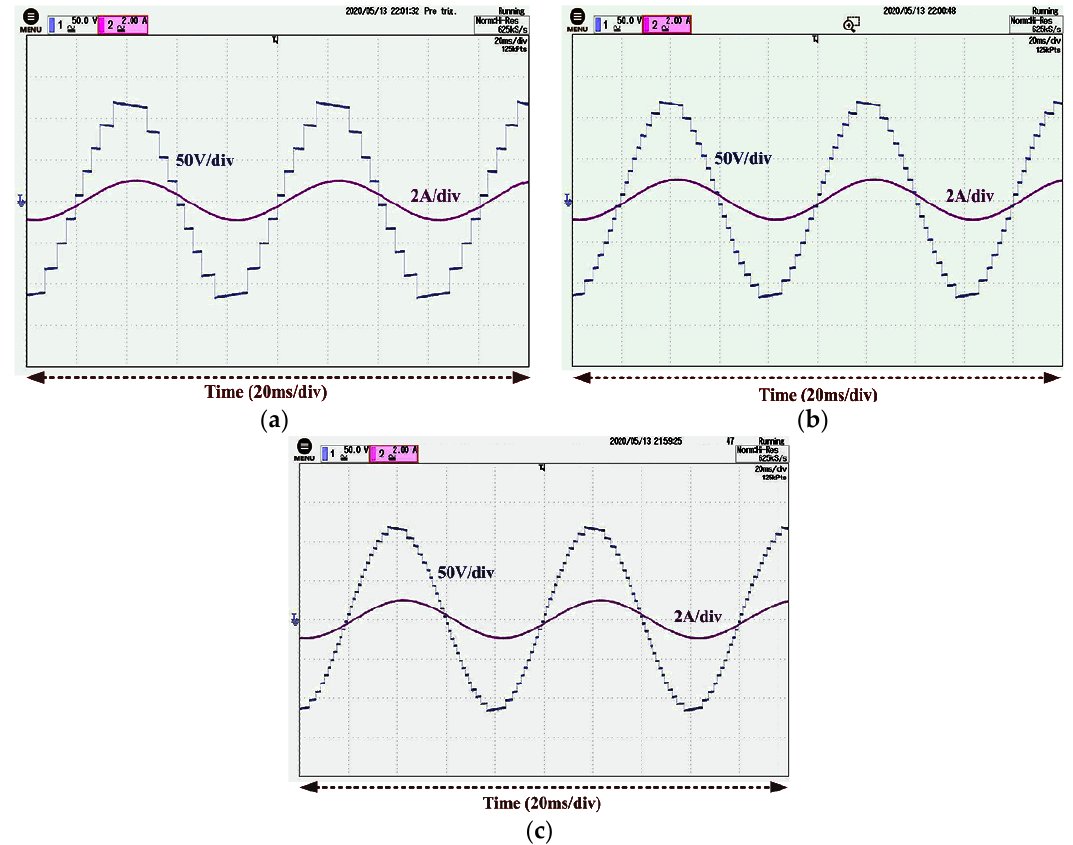
Figure 12. Experimental output voltage and current waveform results ( a ) 9-Level, ( b ) 17-Level, ( c ) 25-Level.